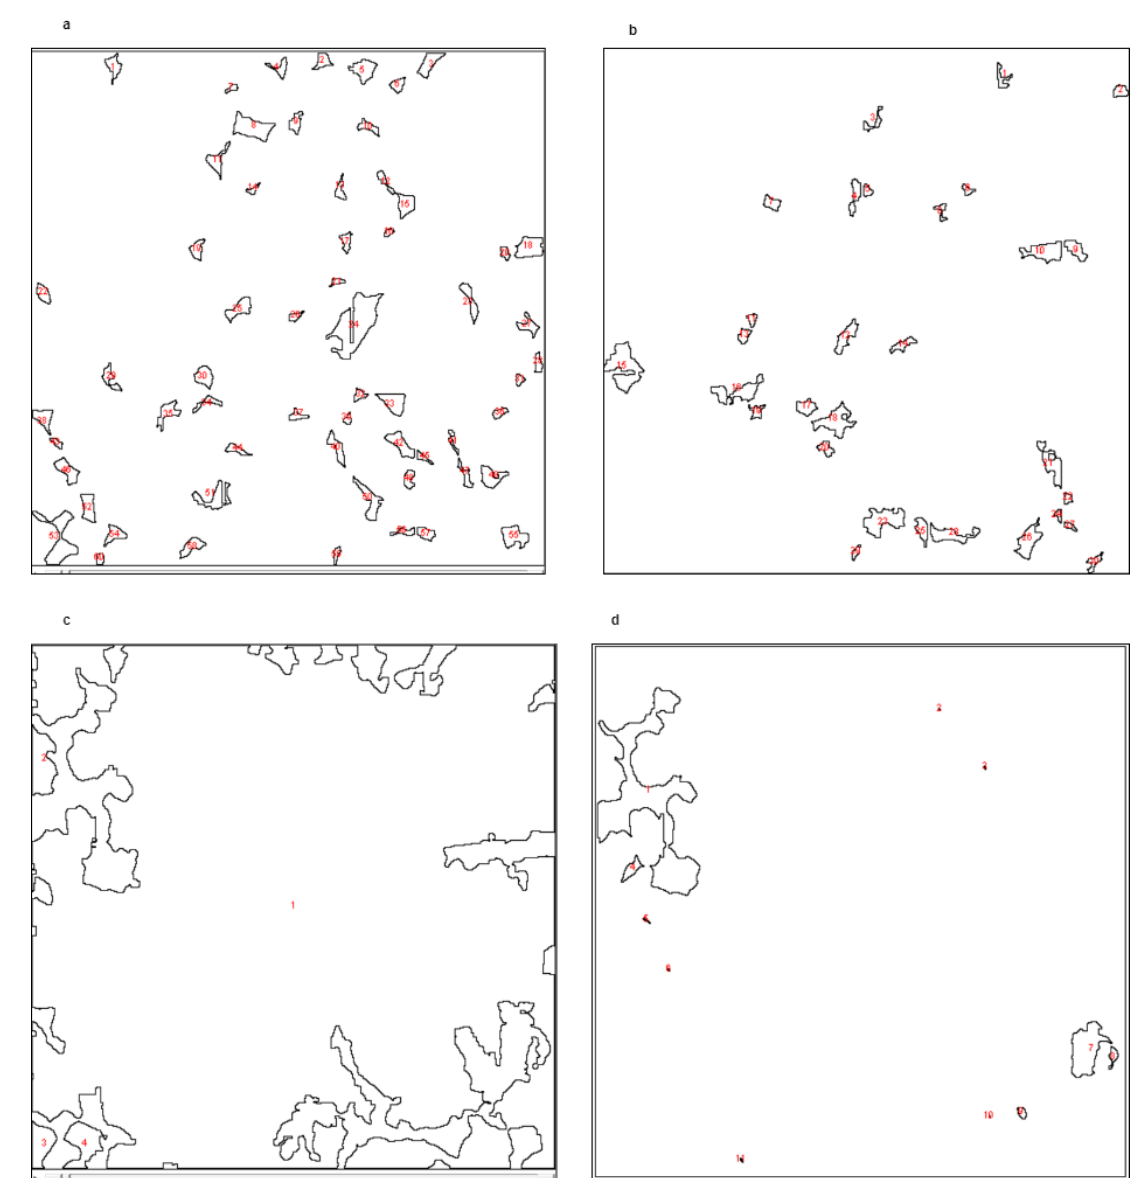
Figure 7. ( a , b ) Separation of particle and count individually (pore and mineral 1. ( c , d ) Separation of particle and count individually (mineral 2 and mineral